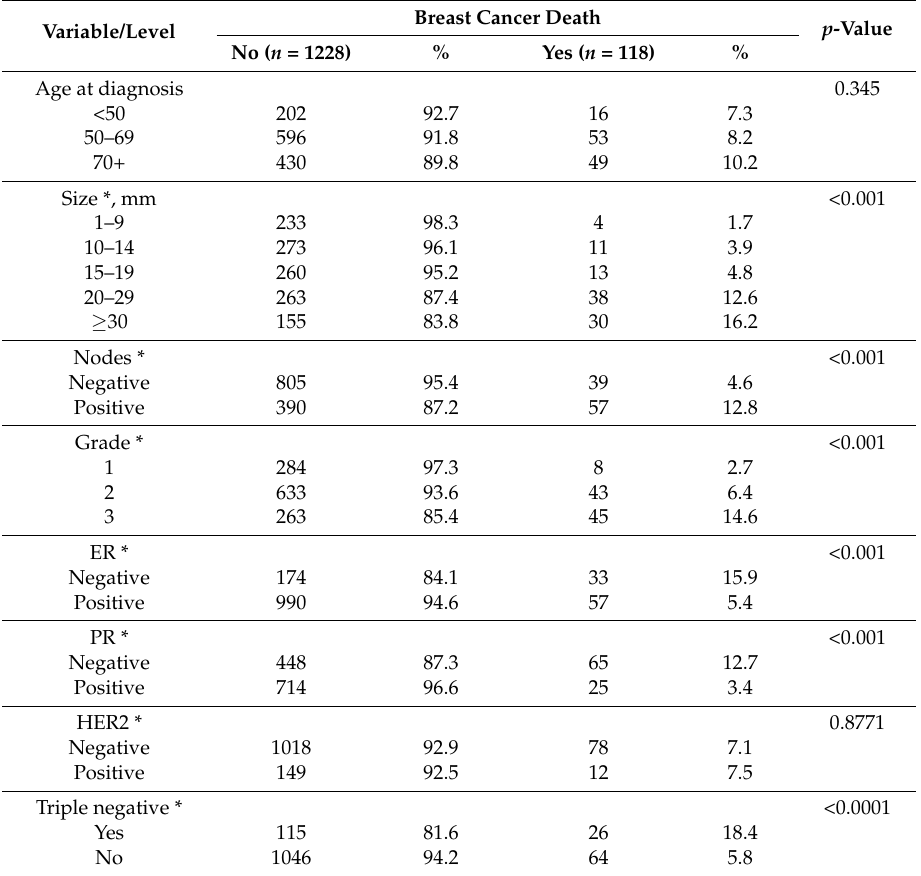
Table 1. The distribution of age at diagnosis, conventional tumor attributes, IHC markers (ER, PR, HER2, Triple negative), mammographic appearance, and treatment by status of breast cancer